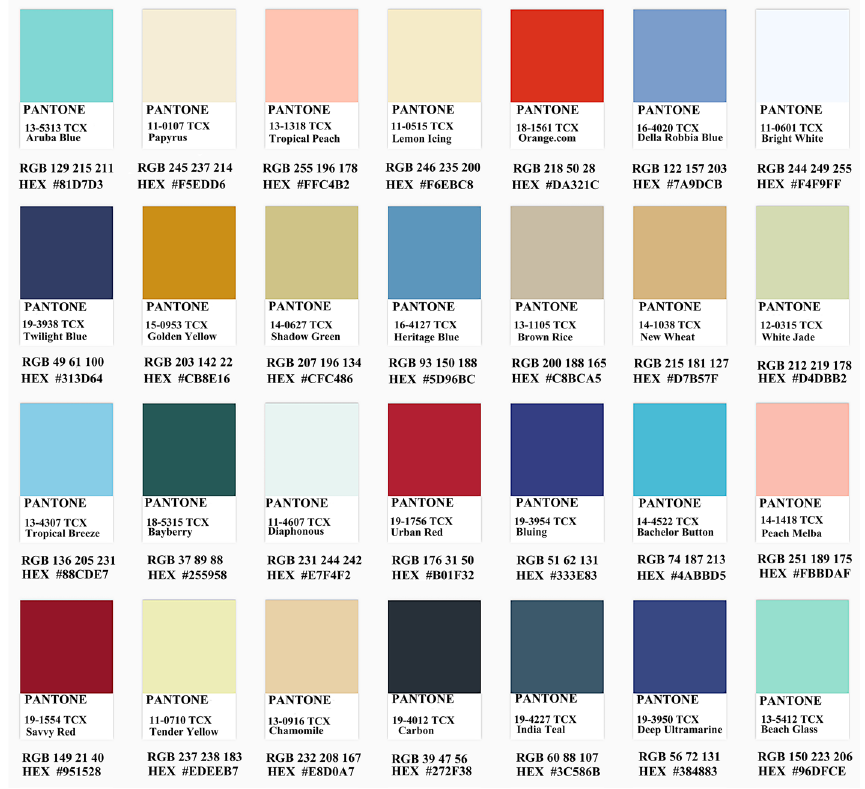
Fig. 3. Among the twelve costumes, the overall color palette is plain and soft, except for embroidered robes and official